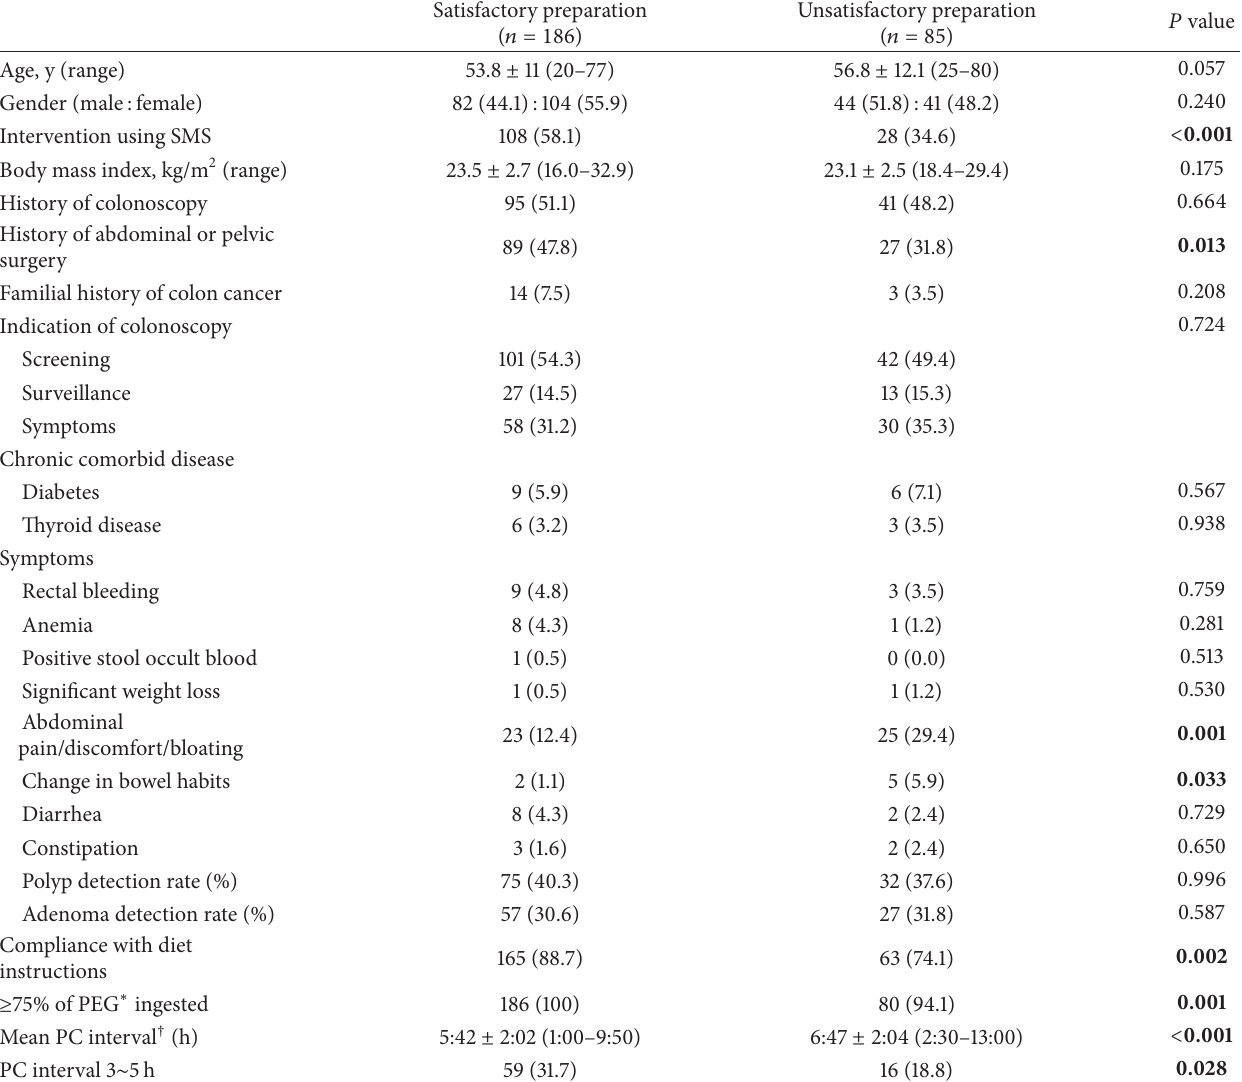
Table 4: Univariate analysis of factors associated with satisfactory bowel preparation (Ottawa Scale 0–5).